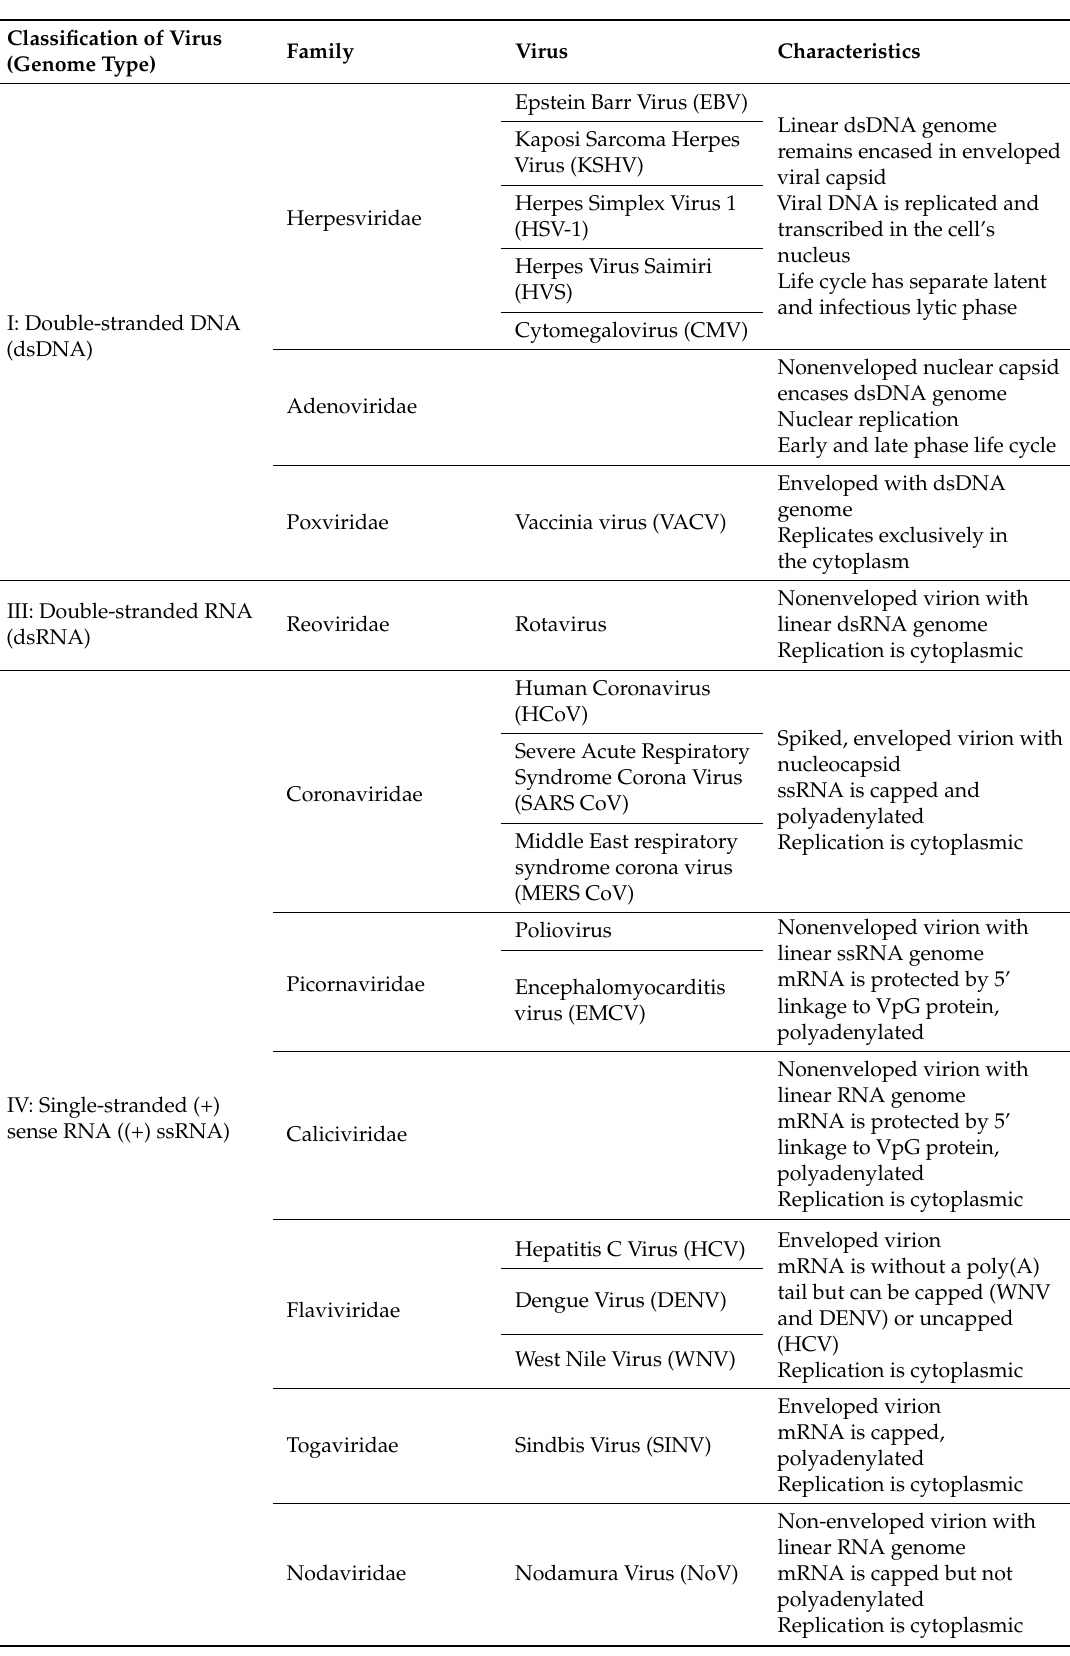
Table 1. Viruses